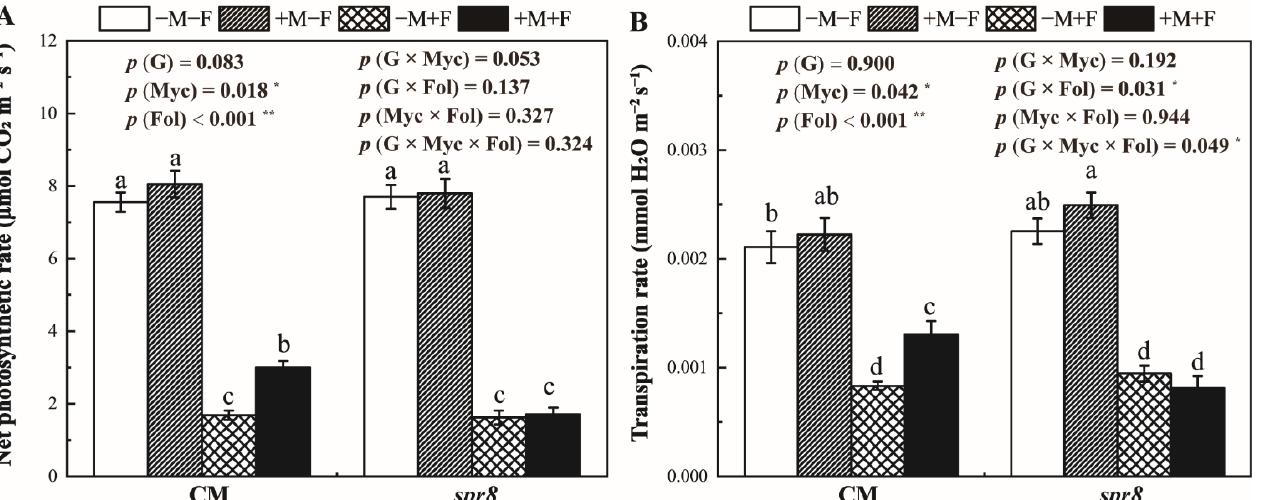
Figure 2. Effects of inoculation with Rhizophagus irregularis inoculation (Myc) and Fusarium ox- ysporum f. sp. Lycopersici (Fol) on the shoot ( A ) and root ( B ) dry weight of tomato CM and spr8 plants (G). − M and +M represent non-inoculation and inoculation with Rhizophagus irregularis , respectively. − F and +F represent non-inoculation and inoculation with Fusarium oxysporum f. sp. Lycopersici , re- spectively. Same lowercase letters above the columns indicate non-significant difference ( p < 0.05) between corresponding treatments. *— p < 0.05; **— p < 0.01.